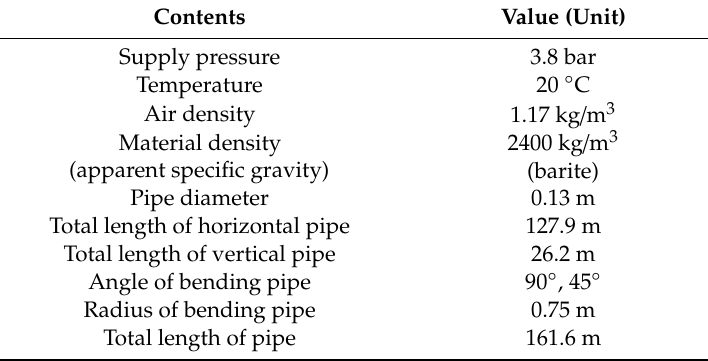
Table 2. Specifications of pressure loss model of BTS.